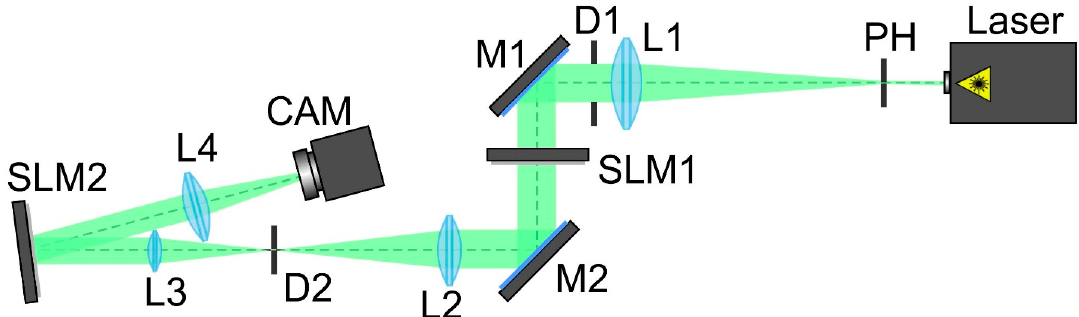
Figure 5. The experimental setup for detecting the TC of a vortex beam using a multi-channel DOE. Laser is a solid-state laser ( λ = 532 nm); PH is a pinhole (hole size of 40 μ m); L1, L2, L3 and L4 are spherical lenses ( f 1 = 350 mm, f 2 = 300 mm, f 3 = 200 mm and f 4 = 250 mm); SLM1 is a transparent spatial light modulator (HOLOEYE LC 2012); SLM2 is a reflective spatial light modulator (HOLOEYE PLUTO VIS); D1 and D2 are circular apertures; M1 and M2 are mirrors; CAM is a ToupCam UCMOS08000KPB video